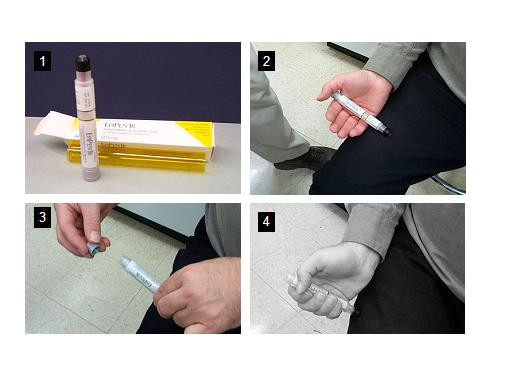
Administration of Epipen auto–injector. Panel 1 shows an auto–injector, and panels 2–4 demonstrate steps in arming the autoinjector and self-administration technique. The patient should grip the unit with the black tip pointing downward (panel 2) and proceed to pull off the gray safety release (panel 3). The injector should then be applied at a 90° angle with the outer thigh and held firmly for approximately 10 seconds after a click is heard (panel 4).